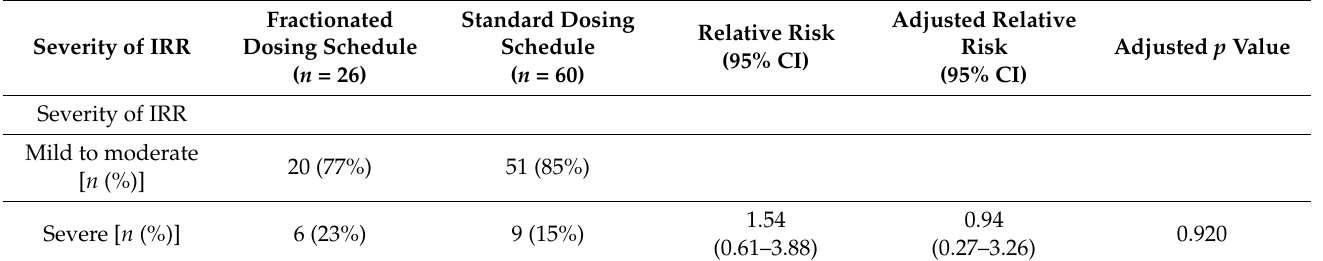
Table 5. Severity of infusion-related reactions according to infusion